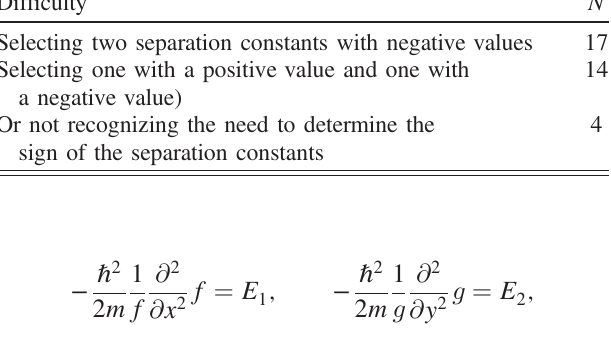
TABLE II. Difficulties in step C2: determining the separation constants. Difficulty N Selecting two separation constants with negative values